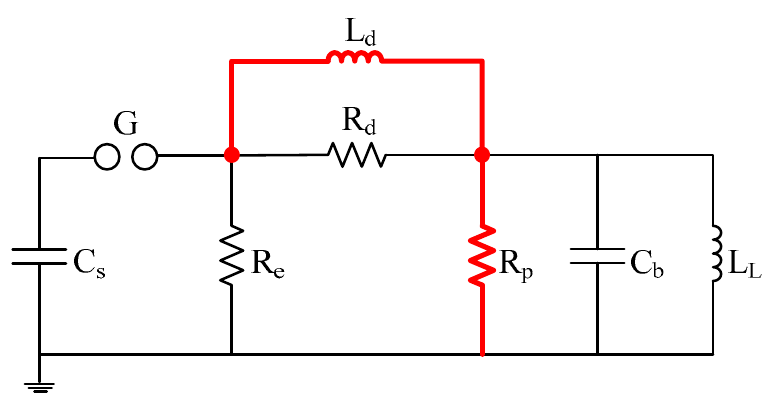
Figure 3. Glaninger’s circuit with a winding load for the impulse voltage generation.